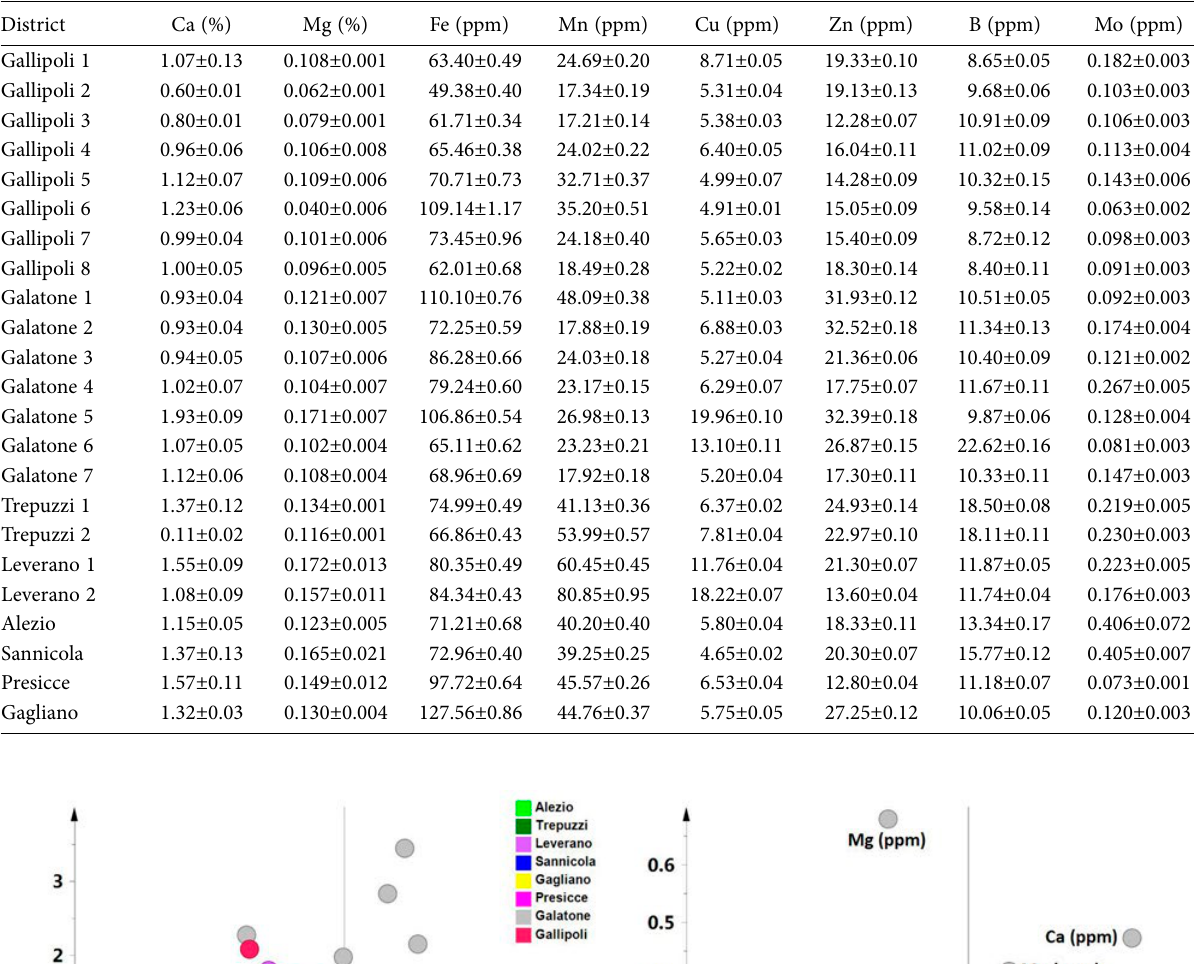
Table 2. Calcium, magnesium and micronutrient contents in olive leaves sampled in Gallipoli, Galatone and other districts of Lecce prov- ince, from farms showing the olive quick decline syndrome and infections by Xylella fastidiosa subsp. pauca . For each farm, data show the means (± standard deviation) of 12 samples collected from three different trees. Data are referred to leaf dry weight.